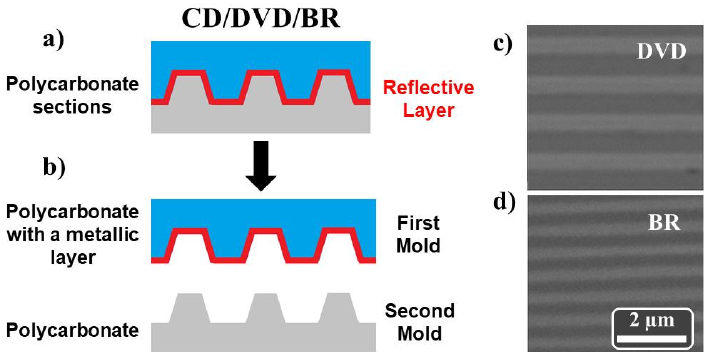
Figure 2. Schematic diagrams of the CD, DVD or BR disk media before ( a ) and after ( b ) the separation of the polycarbonate sections. SEM images of the polycarbonate stamp with a metallic layer obtained from ( c ) DVD and ( d ) BR disks.